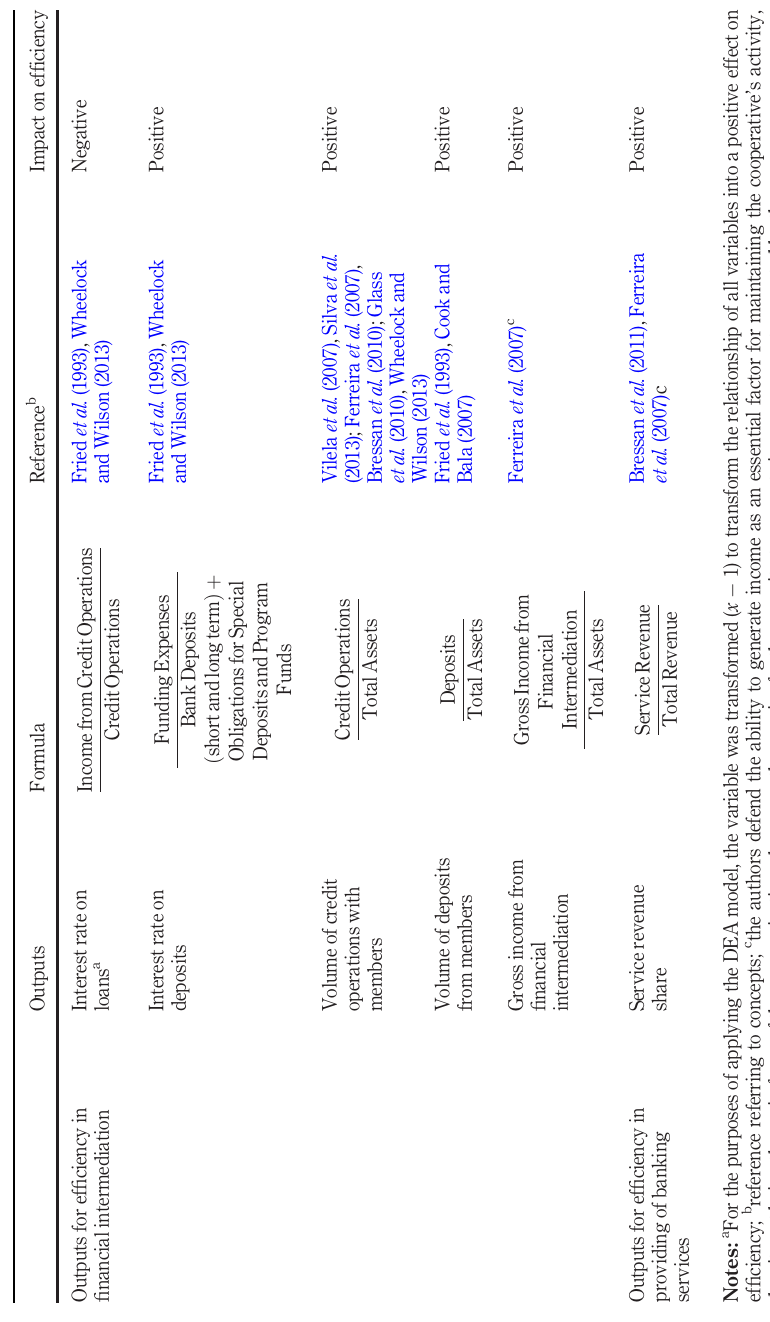
Table 1. Outputs of efficiency